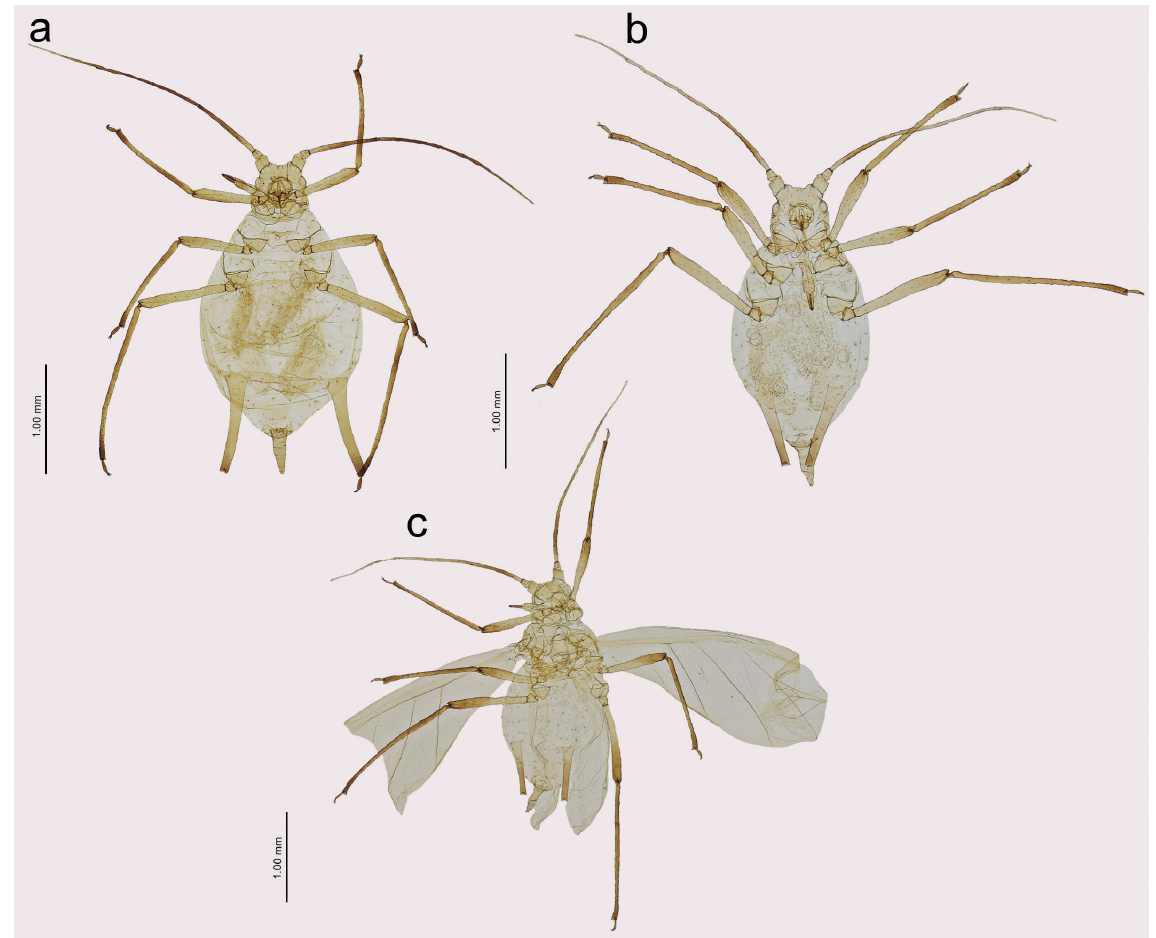
Fig. 1. New species of Uroleucon Mordvilko, 1914 feeding on Grindelia Willd. a . Uroleucon ( Lambersius ) robinsoni sp. nov., holotype, apterous viviparous female (NHMUK 010121495) b . U. ( L. ) grindeliae sp. nov., holotype, apterous viviparous female (NHMUK 010121473) c . U. ( L. ) grindeliae sp. nov., paratype, alate viviparous female (NHMUK